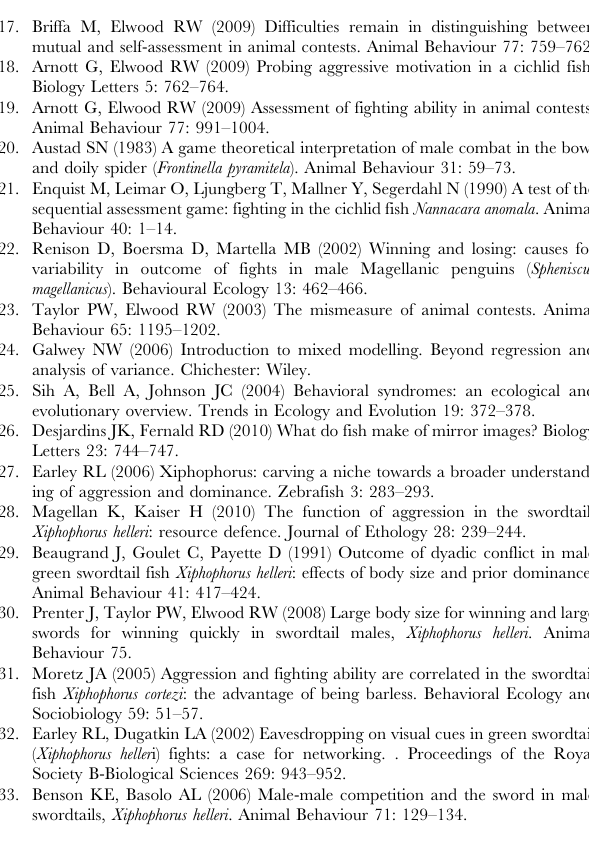
Figure S1 Estimated power curves for the detection of trait repeatabilities from a sample size of 30 individuals with 2 (dotted line), 3 (dashed line) or 4 (solid line) repeat observations per individual. Power is estimated as the proportion of simulated data sets (with n= 200) for which the individual variance component is statistically significant at a = 0.05 based on a one-tailed likelihood ratio test (see main text for details). With a simulated repeatability of zero the power estimate is therefore an estimate of the type I error